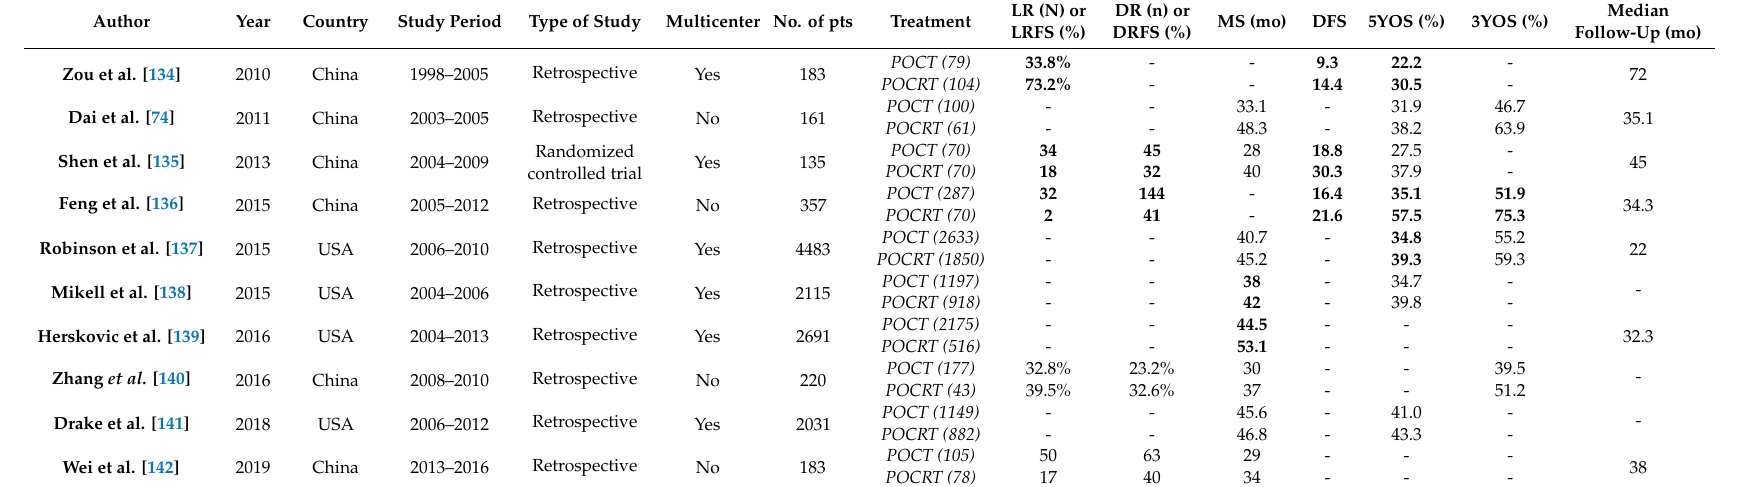
Table 3. Studies reporting the outcomes of completely resected IIIA-pN2 patients treated with postoperative chemo-radiotherapy (POCRT) or POCT alone over the last 20 years. Di ff erence of values in bold is statistically